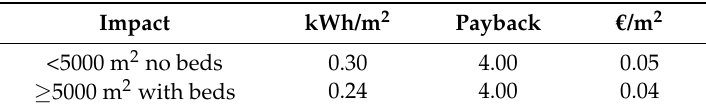
Table 1. Potential of energy saving derived from optimal sizing of